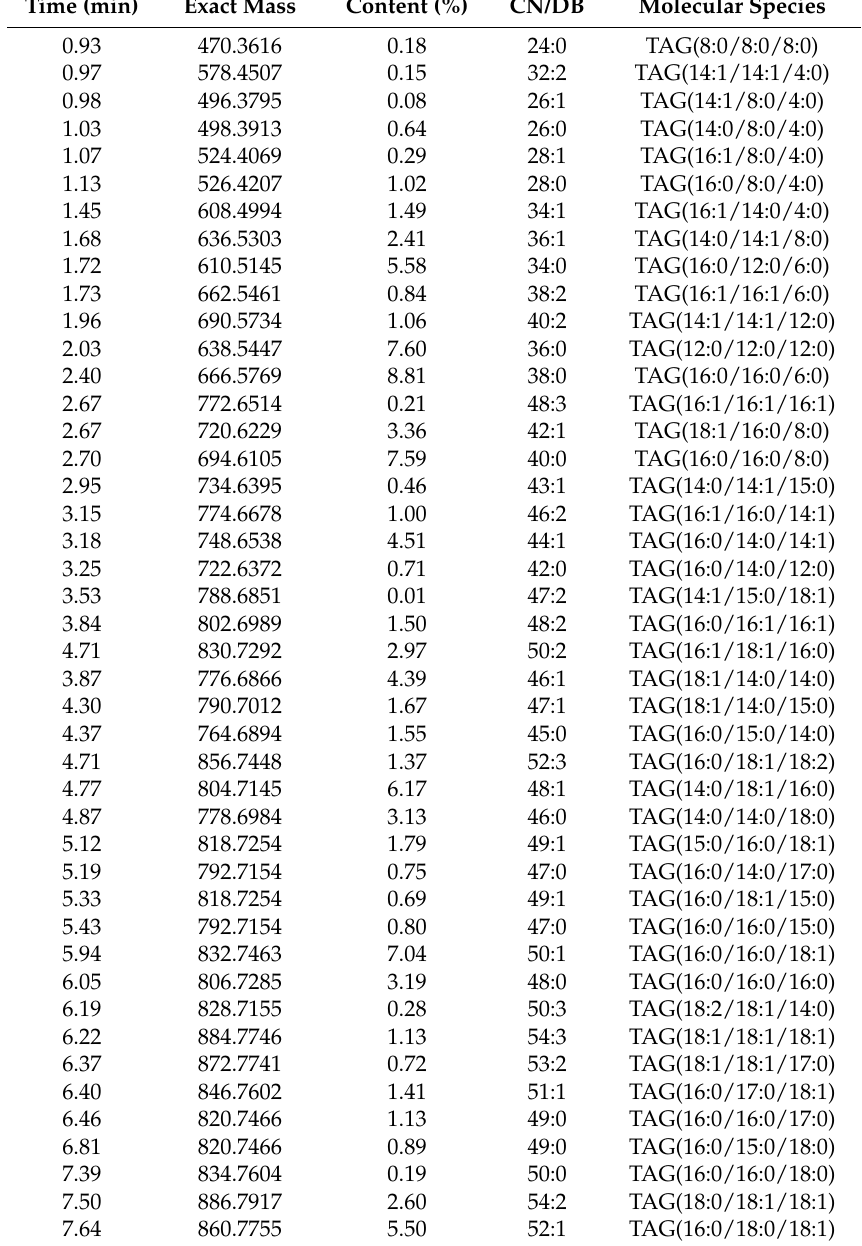
Table 3. Triacylglicerol (TAG) molecular species content in the isolated lipid fraction F2 obtained from buttermilk ordered by carbon number (CN) and double bonds (DB) as determined by